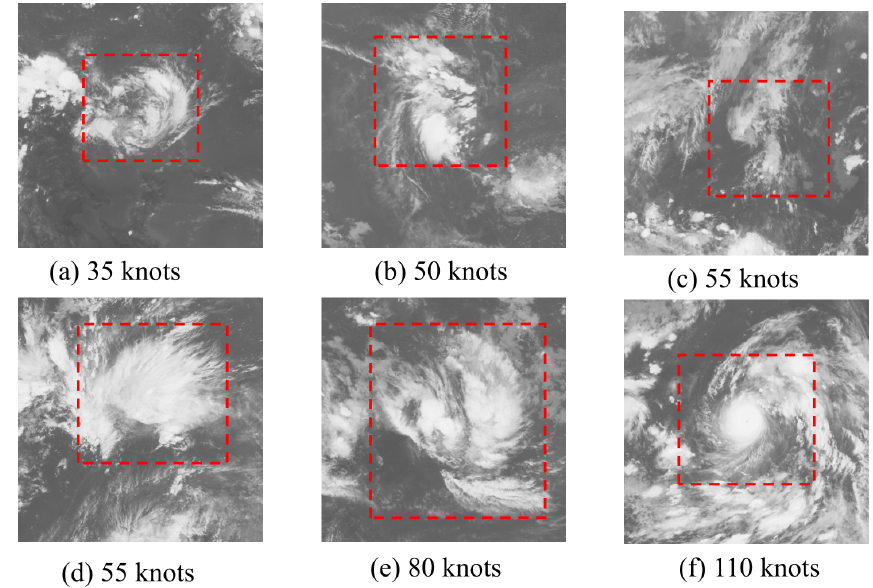
Figure 8. L images of TCs with varied intensity misjudged as non-TC images during testing process (main TC structures are demarcated by red dash squares).